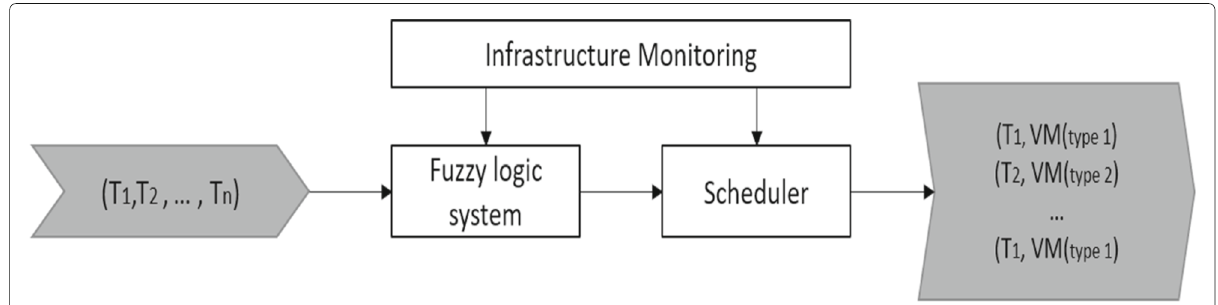
Fig. 6 Task selection phase